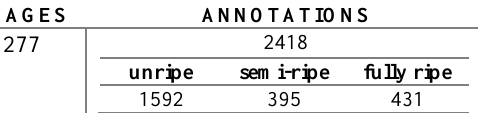
Table 2. Images and annotations of tomatOD dataset